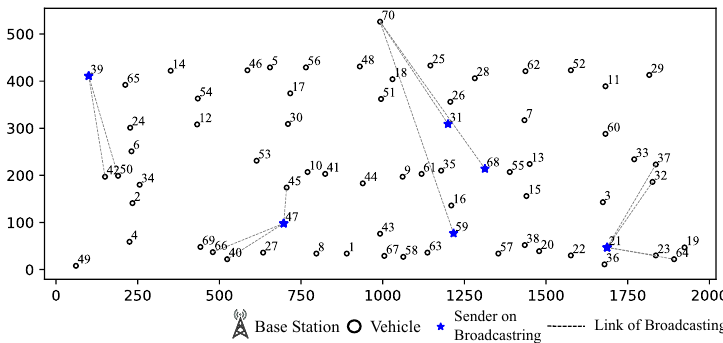
Figure 15. Example of IA in 20th Time